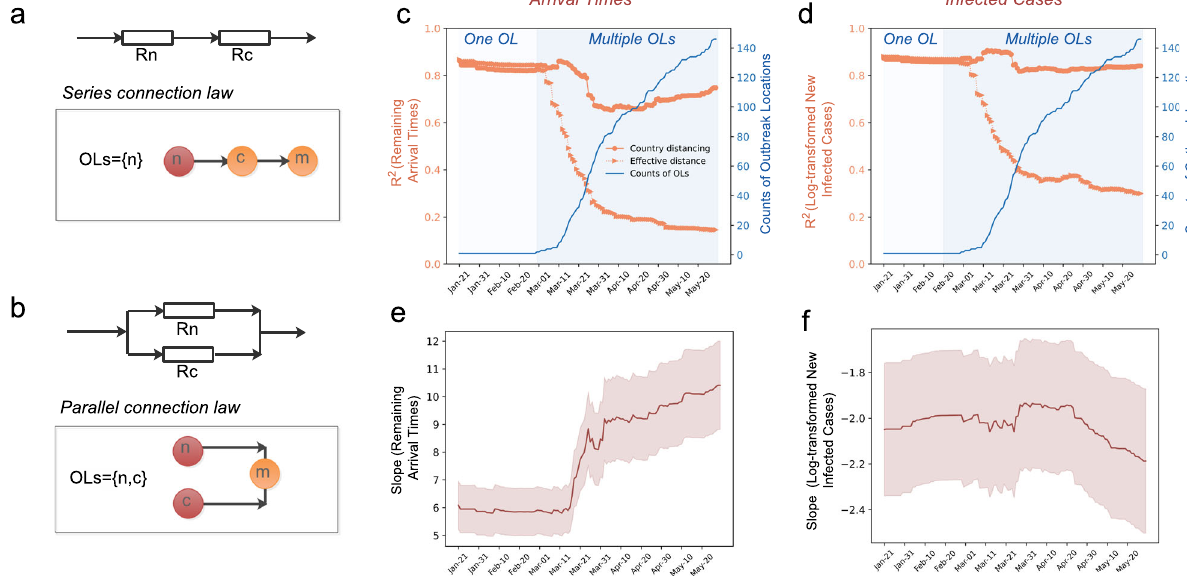
Fig. 2 Global disease dynamics using country distancing when the outbreak locations (OLs) are evolving. By deriving the series and parallel connection law ( a , b ) for global disease transmission, we derive the country distancing method to capture the global disease spread dynamics, i.e., the arrival times and new infected cases. R n and R c represent the resistances in the circuit. Nodes n , c , and m represent the geographical areas and the directed links between the nodes represent the traf fi c fl ow. The disease propagates from one OL (e.g., n ) to destination m , on par with series connection law; whereas the disease propagates from multiple OLs (e.g., n and c ) to destination m , on par with parallel connection law. c , d separately show the R -squared values ( R 2 ) for evaluating global disease dynamics versus country distancing and effective distance. Country distancing correlates strongly with remaining arrival times T t ) ( c ) and log-transformed new infected cases I t ) − I t − 1) ( d ) when multiple OLs are present. The R 2 values for country distancing keep above than m ( m ( m ( 0.7 although OLs are shifting, whereas the R 2 values for effective distance decline sharply given that multiple OLs emerge. e , f are the slopes of linear correlations for c and d , representing the speed of arrival times and speed of infection. The shaded areas are the 95% con fi dence intervals for the speeds. Outbreak locations are de fi ned as the geographic areas whose active con fi rmed case greater than 0.01% population. On 1 June 2020, 146 geographical areas are OLs. Similar to Fig. 1, both arrival time and infected cases are obtained from the meta-population susceptible – infected – removed